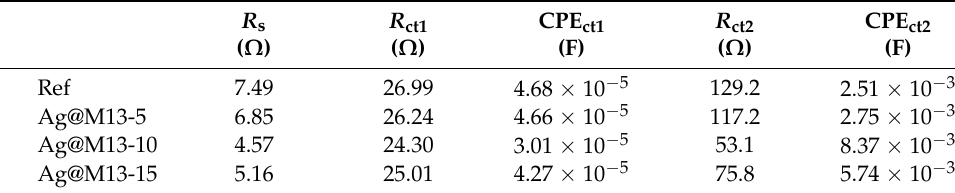
Figure 4. Electrochemical properties of the Ag@M13 enhanced FDSSCs: ( a ) Nyquist plots and onset point of Nyquist plots in the high-frequency region (inset), ( b ) CV characteristics. The three-electrode system, measured at a scan rate of 200 mV s − 1 , contains an Ag/AgCl as a reference electrode, Pt wires as working and counter electrodes, respectively. Normalized η / η 0 of Ag@M13-10 enhanced FDSSCs as a function of ( c ) bending cycles and ( d ) washing cycles. The inset in Figure 4c is the normalized η / η 0 under extreme bending conditions, such as radii 2.5, 5.0, and 7.5 mm. Table 2. EIS parameters of SS-FDSSCs as a function of Ag@M13.